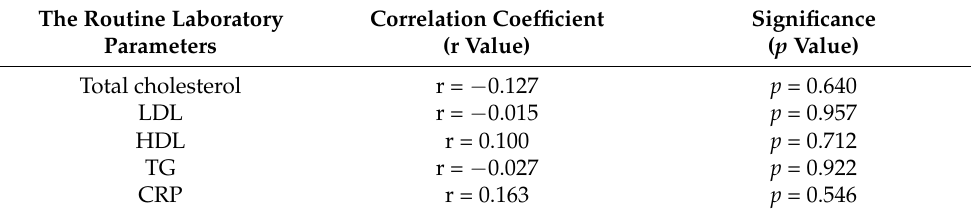
Table 5. Correlation between the routine laboratory parameters and the PACAP levels.